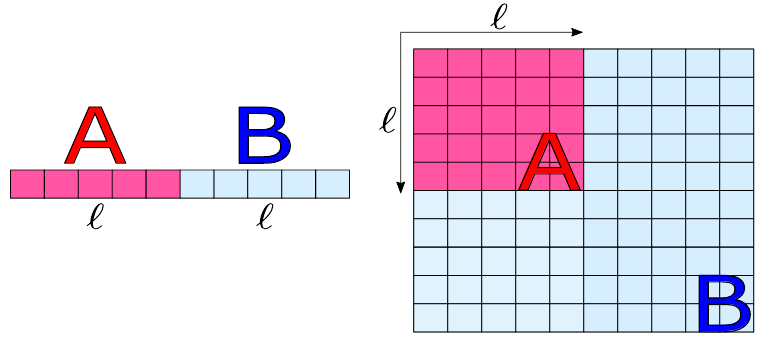
Figure 6: Example systems: (left) 1D chain under equal spatial bipartitions of size ℓ and (right) a square lattice with square spatial subregion of linear size ℓ . The total number of sites in the subregions is m ≡ ℓ D . Periodic boundary conditions are used in all